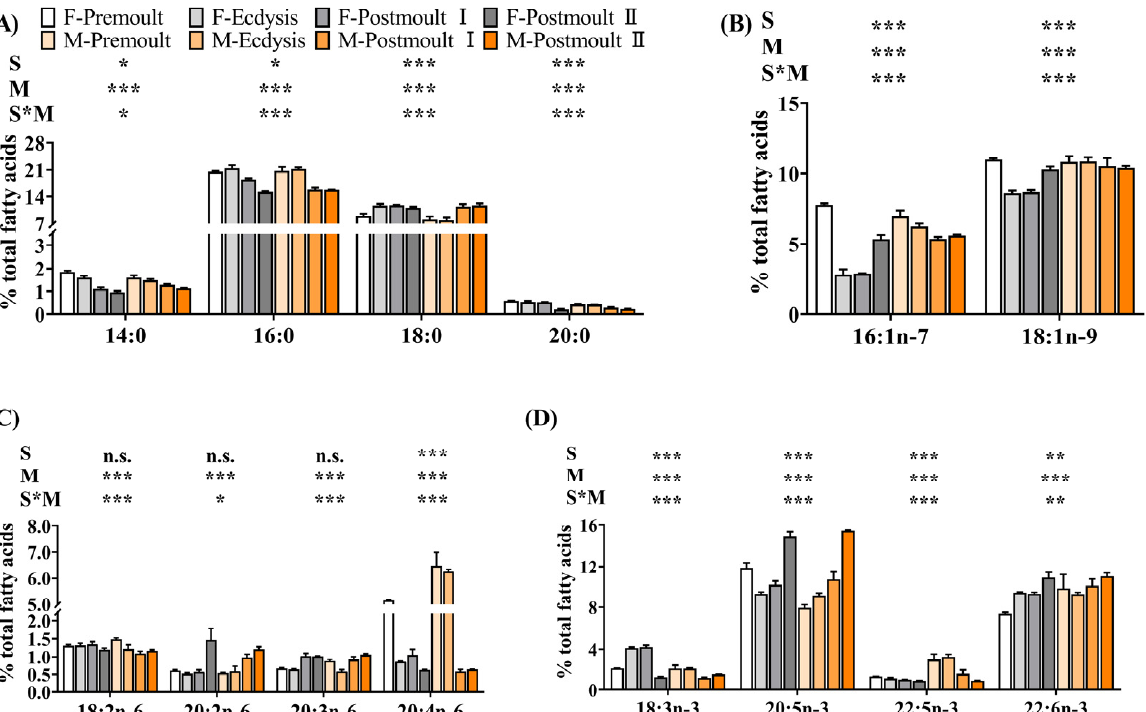
Figure 7. Effects of sex and moult stages on the fatty acid composition (% total fatty acids) of the edible part of mud crab. ( A ) SFA, saturated fatty acids, such as 14:0, 16:0, 18:0, and 20:0; ( B ) MUFA, mono-unsaturated fatty acids, such as 16:1n-7 and 18:1n-9; ( C ) n-6 PUFA, n-6 polyunsatu- rated fatty acids, such as 18:2n-6, 20:2n-6, 20:3n-6 and 20:4n-6; ( D ) n-3 PUFA, n-3 polyunsaturated